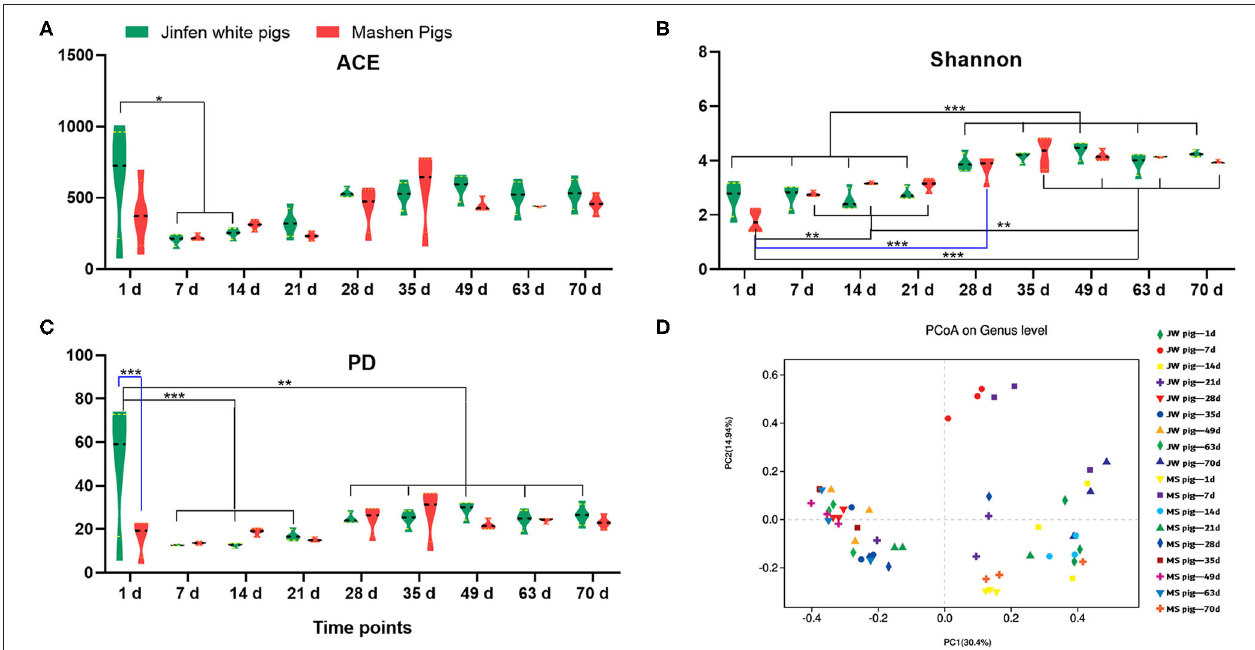
FIGURE 3 | Analysis of the fecal microbiota diversity of Jinfen White and Mashen piglets. (A) ACE indices, (B) Shannon indices, (C) PD indices, and (D) PCoA. * P < 0.05, ** P < 0.01, and *** P < 0.001 indicate significant difference among different time